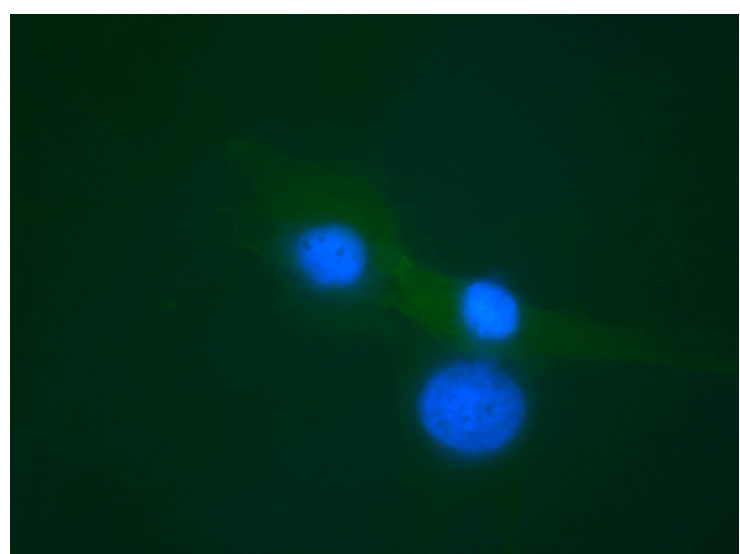
Figure 10. NOF 316 showing SMA expression after stimulation with 1 mg/mL Khat (magnification ×100, Fluorescence at 1.3 s, DAPI at 0.07 s).